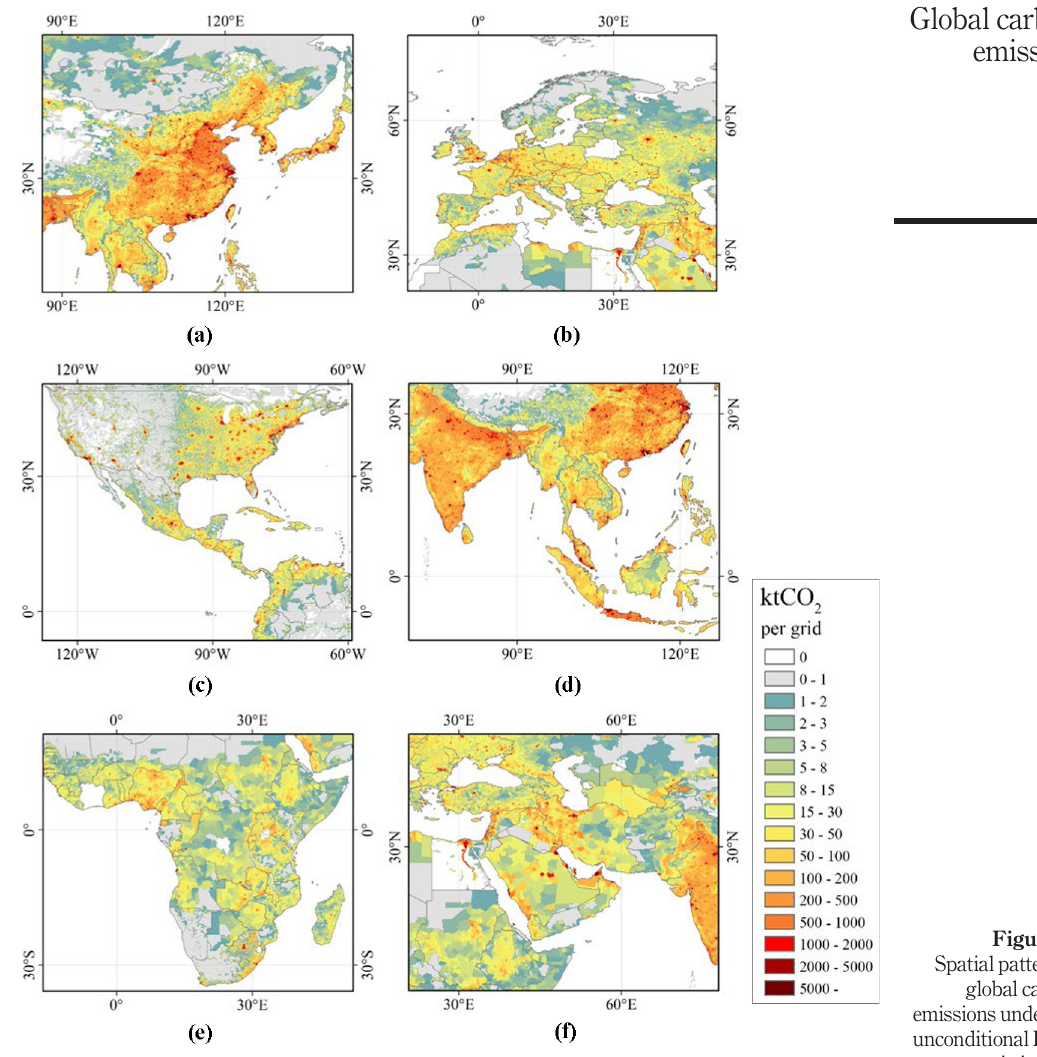
Figure 7. Spatial pattern of global carbon emissions under the unconditional INDC scenario in